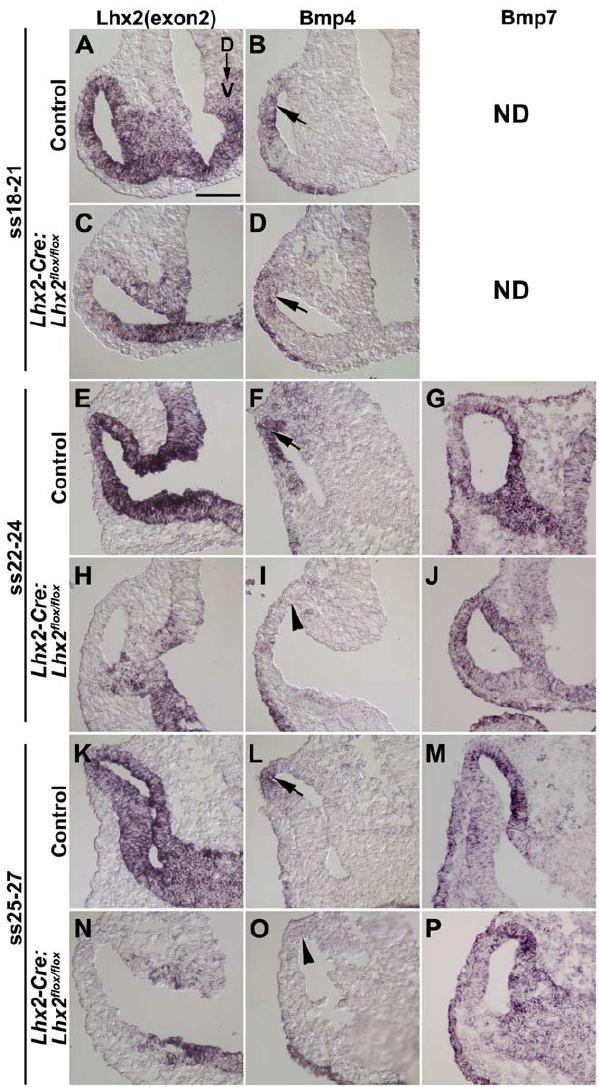
Figure 5. Differential regulation of Bmp4 and Bmp7 expression by Lhx2. (A–P) In situ hybridisation analyses of coronal sections of the optic vesicles in control and mutant ( Lhx2-Cre:Lhx2 flox/flox ) embryos at the indicated developmental stages. A,C,E,H,K,N are in situ hybridisation analyses to detect exon 2 (exon2) in the Lhx2 mRNA to reveal the domain in the optic vesicle where the Lhx2 gene has been inactivated. B,D,F,I,L,O are in situ hybridisation analyses to detect expression of Bmp4 . G,J,M,P are in situ hybridisation analyses to detect expression of Bmp7 . Bmp4 expression is initiated dorsally in control embryos (B) and in the conditional mutants (D) at ss18–21 (arrows). Bmp4 expression is maintained in the controls at later developmental stages (F,L) whereas the expression is down-regulated in the conditional mutants at later developmental stages (I,O, arrow heads). Bmp7 expression is initiated and maintained in both the control embryos (G,M) and conditional mutants (J,P) at ss22–24 and at ss25–27. ND, not done. Dorsal to Ventral orientation for all sections is indicated in A. Scale bar: 100 m